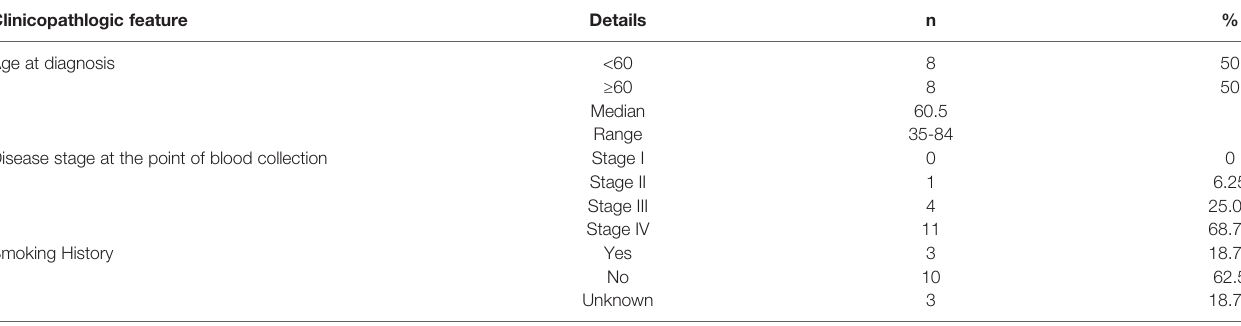
TABLE 1 | The clinicopathological features of lung cancer patients recruited in this study. Clinicopathlogic feature